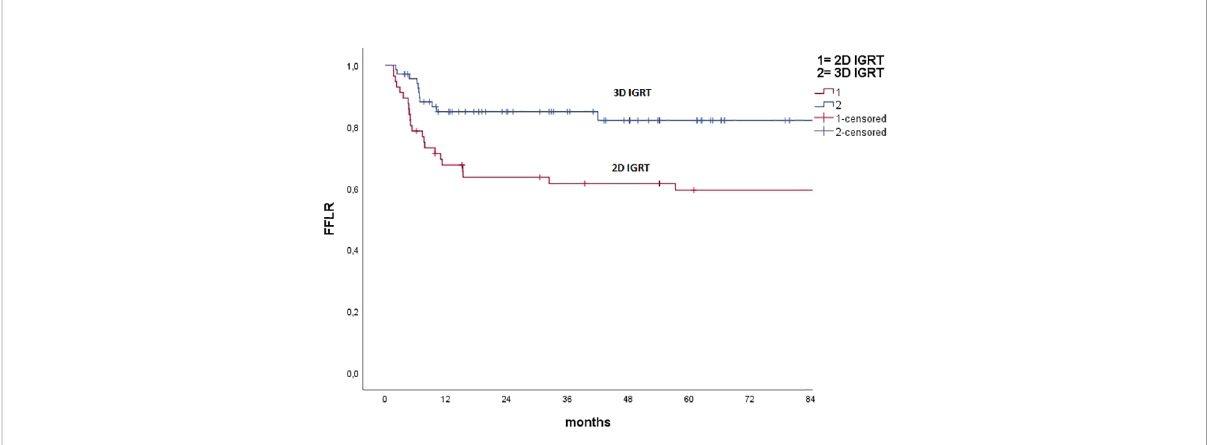
FIGURE 1 Kaplan – Meier curve concerning freedom from local recurrence for pts treated with 2D IGRT (portal imaging) and 3D IGRT.